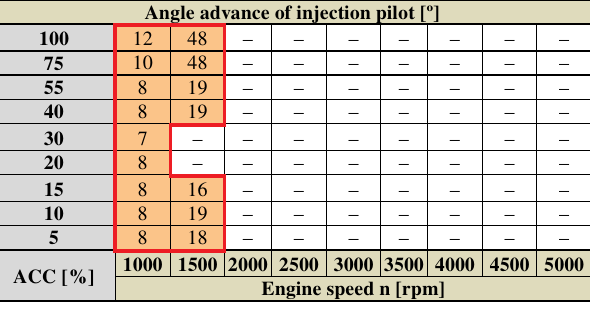
Table 5. Control algorithm of injection advance angle of Diesel oil for Pilot dose at dual fuel supply of the engine Angle advance of injection pilot